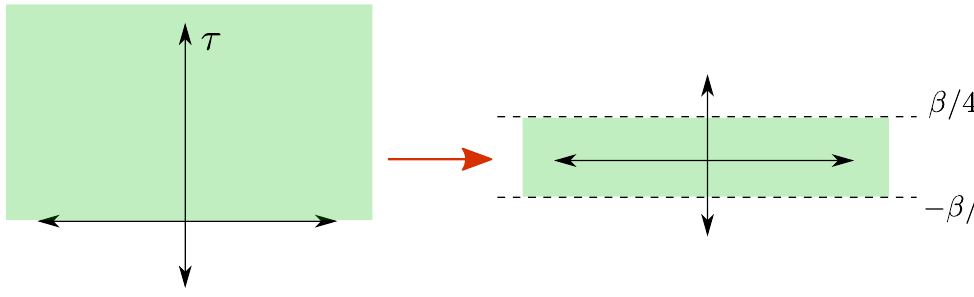
Figure 1 . The coordinate transformation (2.6) maps the UHP to the strip. The state | B i should be thought as prepared on the boundaries of the